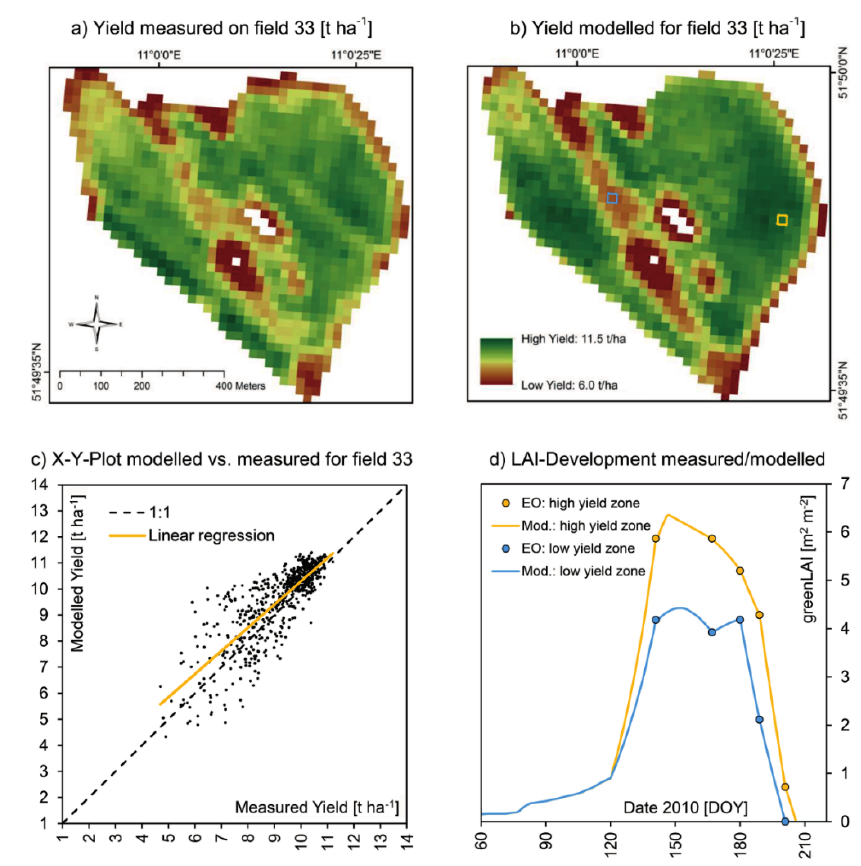
Figure 9. ( a ) Zoom image from Figure 7, showing spatially measured ( a ) and modelled ( b ) yield of winter wheat on test field 33 for the harvesting season of 2010, including an X-Y-plot of the correlation of the two spatial datasets ( c ) as well as the modelled and EO-measured seasonal course of LAI-development for high (yellow pixel) and low (blue pixel) yielding sections of the field ( d ). A quantitative comparison is given in Table